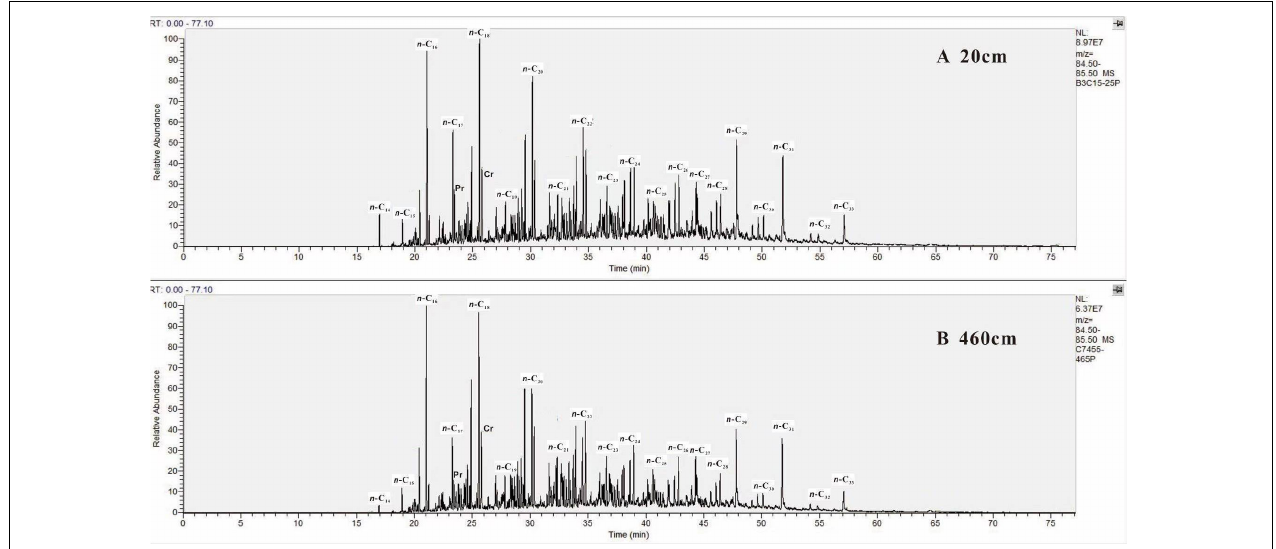
FIGURE 7 | The chromatogram of the typical samples in core sediments (A,B)